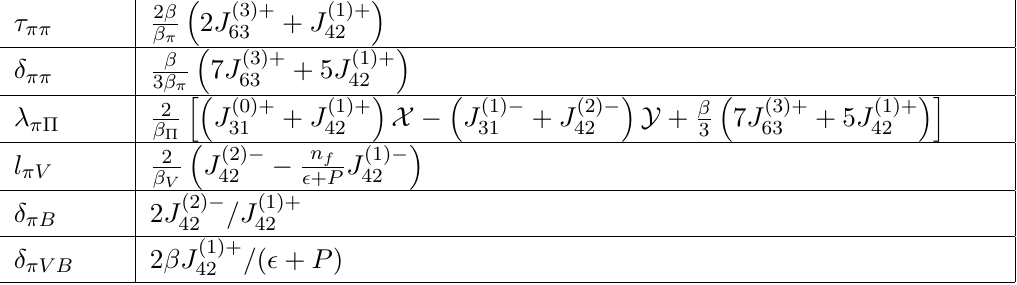
Table 2 . Transport coefficients appearing in shear-stress equation eq. (3.21).